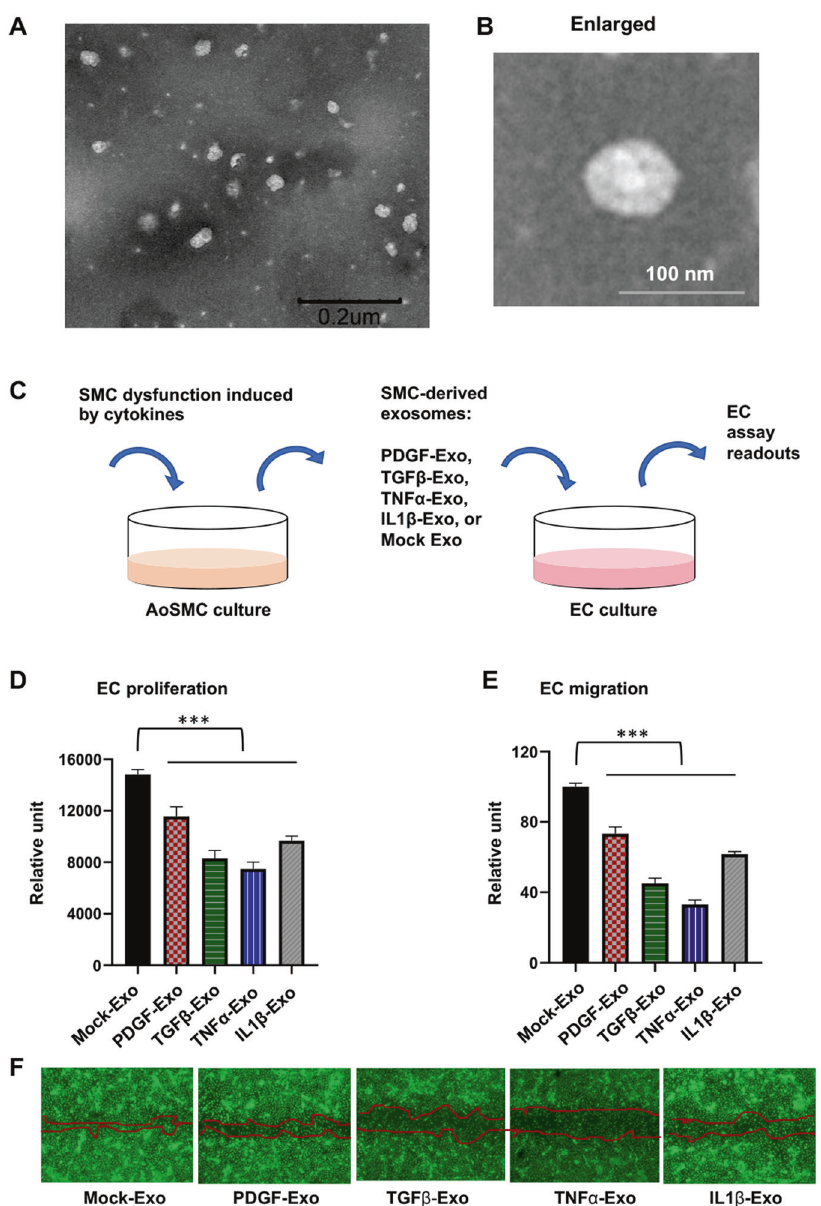
Fig. 1 Inhibitory effect of dysfunctional SMC-derived exosomes on EC proliferation and migration. Human primary aortic smooth muscle cells (AoSMCs) were starved in basal medium (no FBS) and then treated for 24 h without (Mock control) or with a cytokine (50 ng/ml PDGF-BB, 20 ng/ml TGF β 1, 20 ng/ml TNF α , or 10 ng/ml IL1 β ). Exosomes extracted from a conditioned medium were added to human umbilical vascular ECs cultured in full medium and incubated for 48 or 24 h prior to measurements of proliferation and migration, respectively. Data are presented as mean ± SD ( n = 3 replicates). *** P < 0.001 (compared to any of the cytokine conditions), as analyzed with one ‐ way ANOVA followed by Bonferroni post hoc test. A TEM image of SMC-derived exosomes. Puri fi ed exosomes were resuspended in PBS. Scale bar: 200